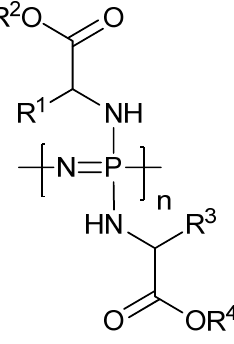
Figure 7. Generic structure for amino acid ester substituted poly[(organo)phosphazenes]. R –R can be varied to give a range of poly[(organo)phosphazenes] with tailored 1 4 degradation